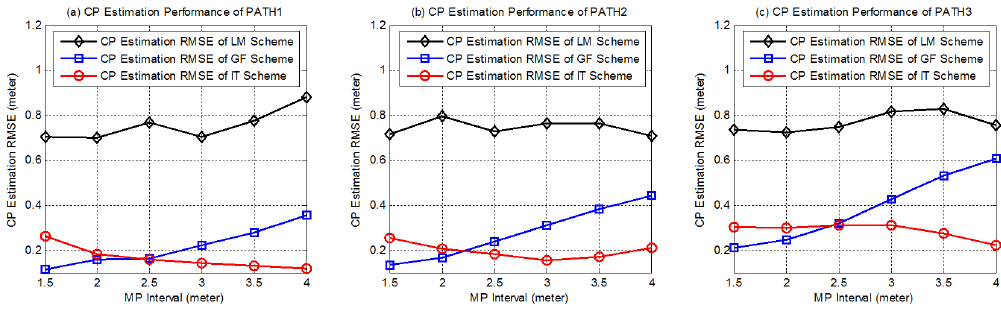
Figure 10. The CP estimation accuracy of the three geometric theorem-based tracking schemes with respect to the LOSL densities when the device-free target walks in three routes with different levels of sinuosity.